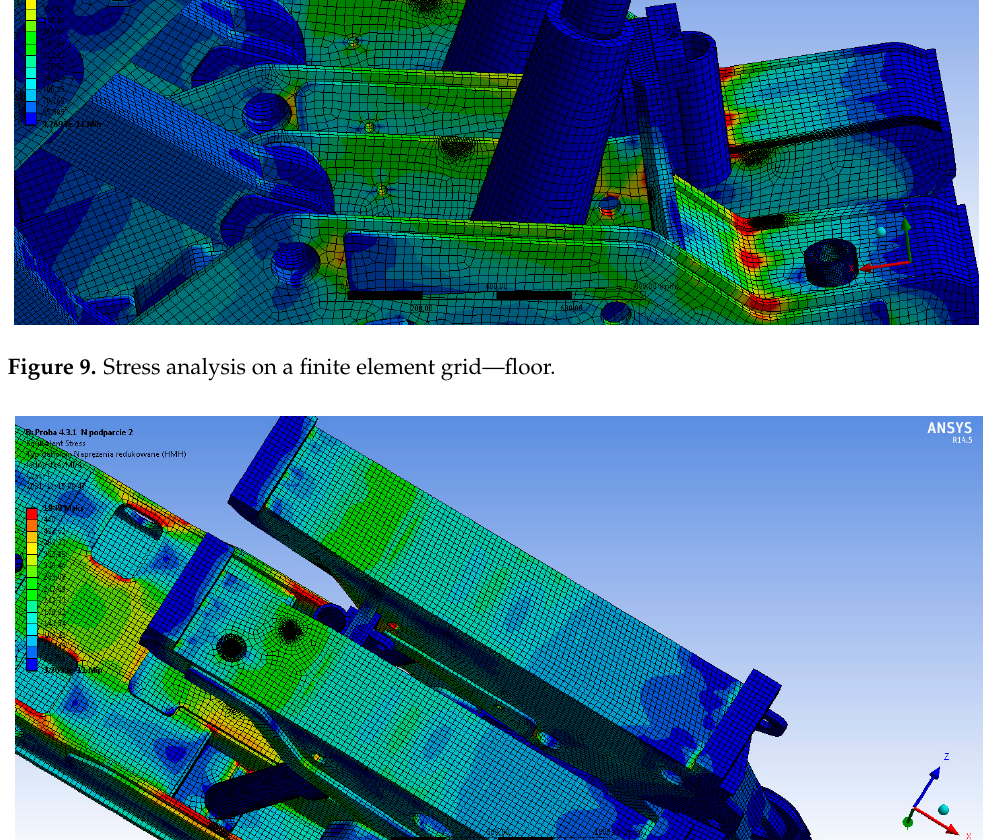
Figure 10. Stress analysis on a finite element grid—floor.